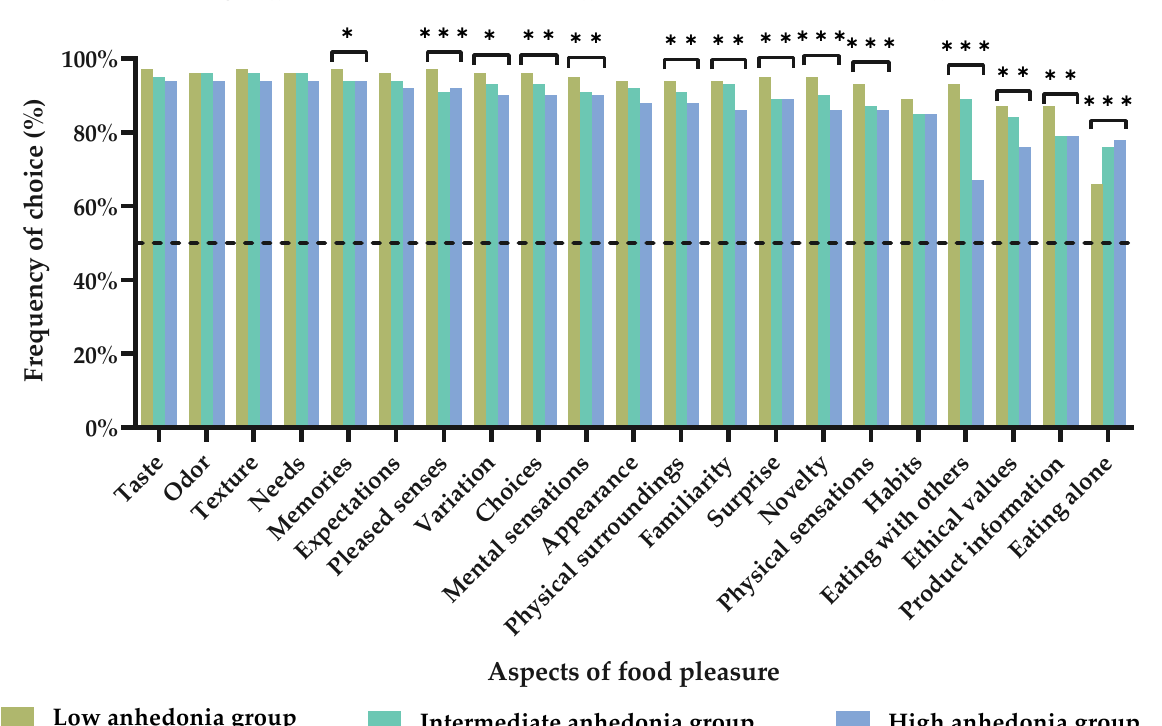
Figure 4. Subjective perception of pleasure from food and food experiences by the 21 different pleasure aspects of the Food Pleasure Scale. Results are shown for the three anhedonia groups: ‘Low anhedonia’ ( n = 537), ‘Intermediate anhedonia’ ( n = 360), and ‘High anhedonia’ ( n = 154). Stars indicate level of significance of p -values. *: p <0.05, **: p < 0.01, and ***: p < 0.001. Dotted line marks 50% frequency.